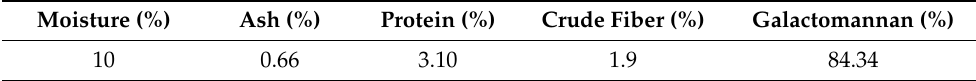
Table 3. Chemical compositions of guar gum.